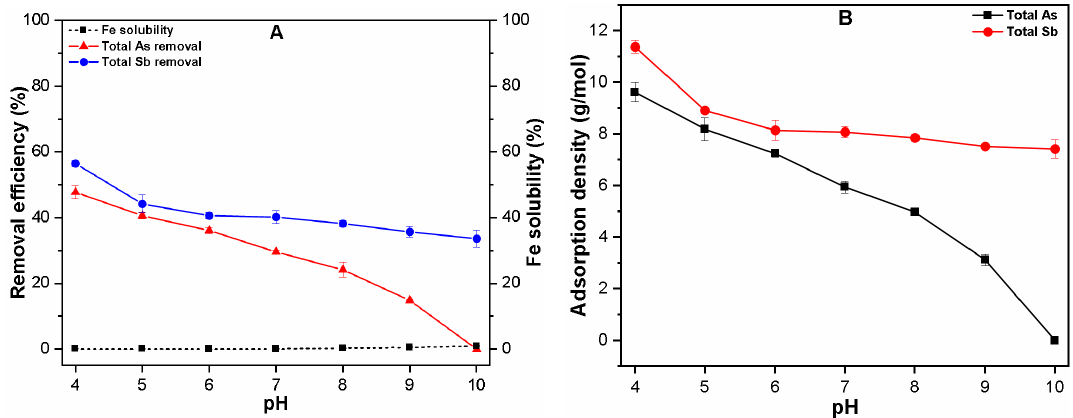
Figure 3. The quaternary system of As and Sb species showing ( A ) Fe solubility (%) and removal efficiency (%); ( B ) Adsorption densities (g/mol) under various pH range (4–10) with 0.1 mM FC coagulant dose.